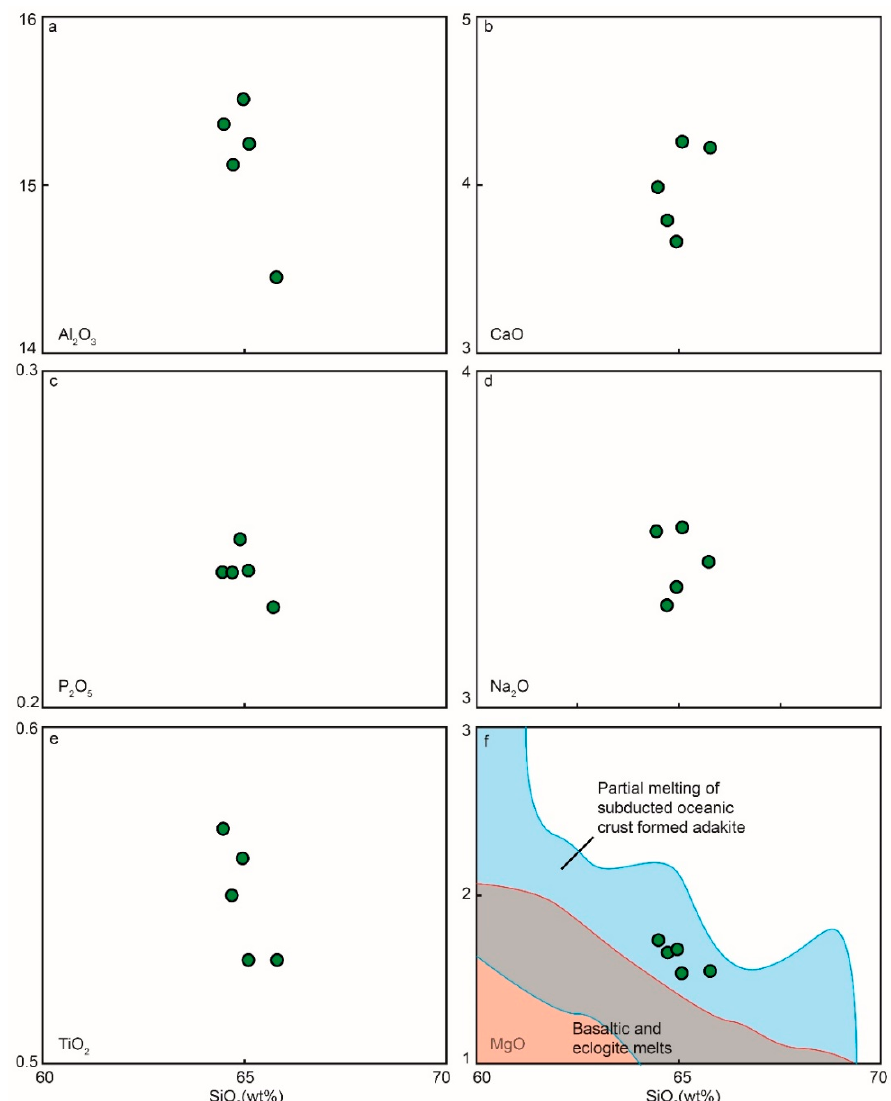
Figure 10. Harker diagram of SiO 2 versus other major elements of Hucunnan granodiorite: ( a ) SiO 2 vs. Al 2 O 3 , ( b ) SiO 2 vs. CaO, ( c ) SiO 2 vs. P 2 O 5 T, ( d ) SiO 2 vs. Na 2 O, ( e ) SiO 2 vs. TiO 2 , ( f ) SiO 2 vs. Mg. MgO and SiO 2 of granodiorite in the area were negatively correlated, reflecting the typical characteristics of subducted oceanic crust melting adakite (Figure 10f) [60]. In the Sr / Y–Y diagram (Figure 11a), all samples show a negative correlation trend and fall within the area of adakite with an a ffi nity of melting of oceanic subduction, which is obviously di ff erent from that of melting of thickened lower continental crust (Figure